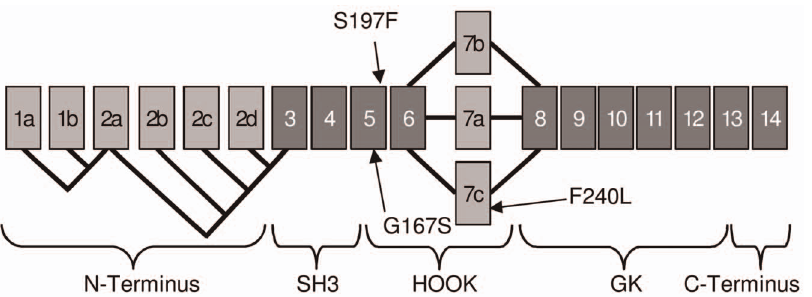
Figure 1. Splice scheme of human CACNB2 resulting in 9 splice variants of the Ca V b 2-subunit with the localization of the three mutations. Spliced exons are shown in light grey and conserved exons in dark grey. All nine splice variants express the mutation-carrying exon 5, while three of variants contain the localization of the third mutation in exon 7c [10].